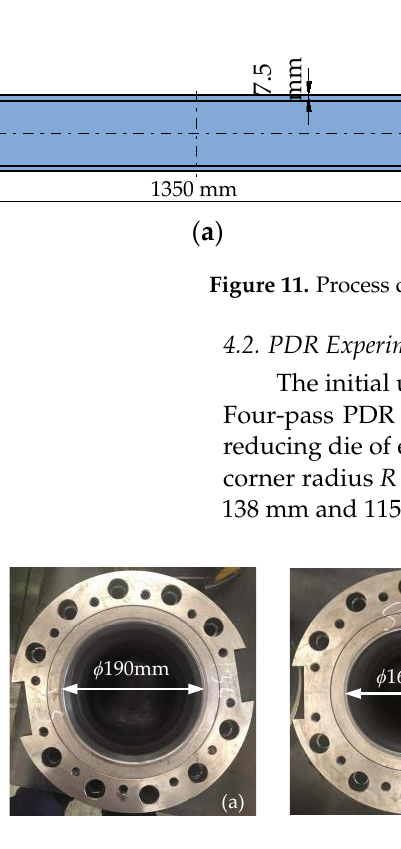
Figure 12. Reducing dies. ( a ) First pass; ( b ) second pass; ( c ) third pass; ( d ) fourth pass.